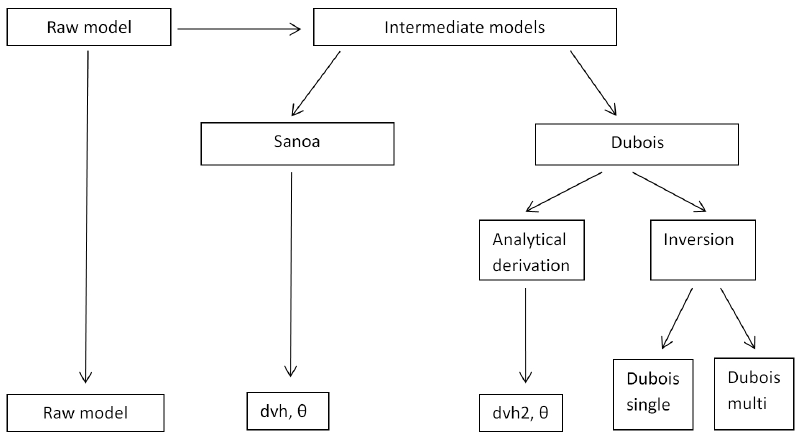
Figure 2. Flow diagram of the variable ( i.e. , predictor) selection procedure. The last row of the diagram comprising of a total of five possible radar predictor groups to be used in the grouped step-wise